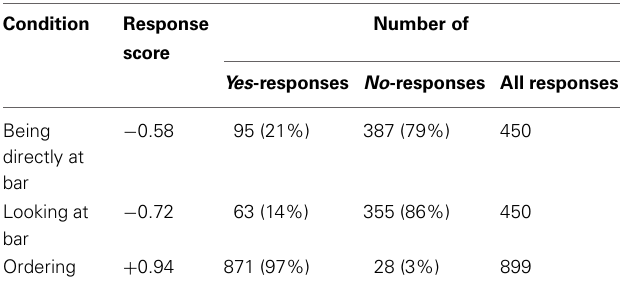
Table 4 | Results of Experiment